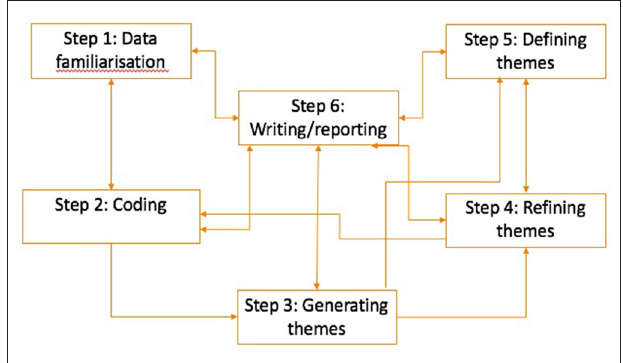
FIGURE 1 | Thematic analysis